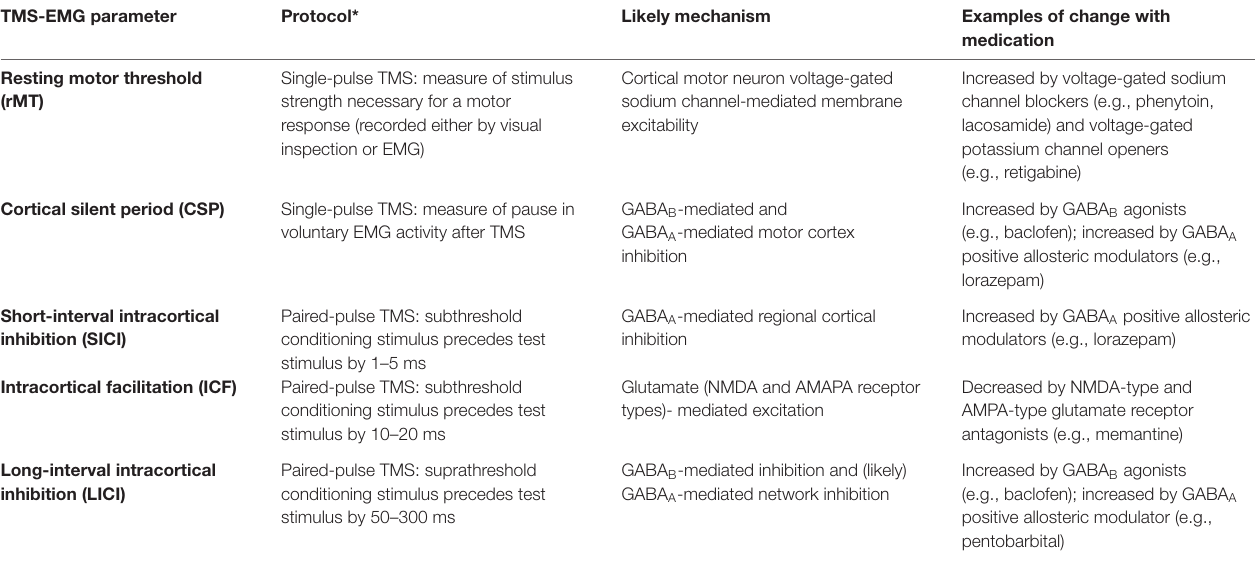
TABLE 1 | Transcranial magnetic stimulation-electromyography (TMS-EMG)